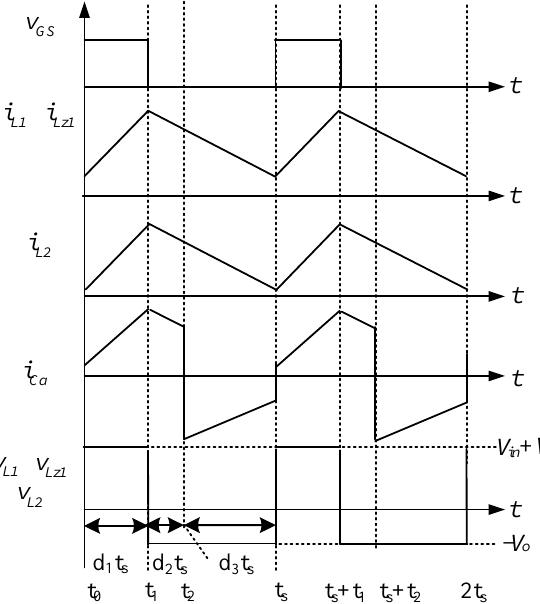
Figure 3. Theoretical waveforms of the proposed converter in CCM.